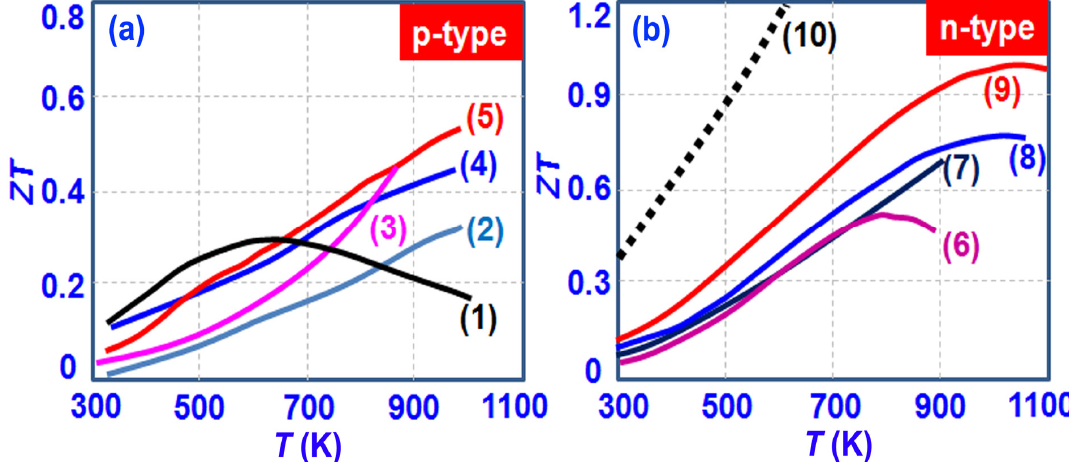
Pd Sb [87]; (2) ZrNi 1 − x x